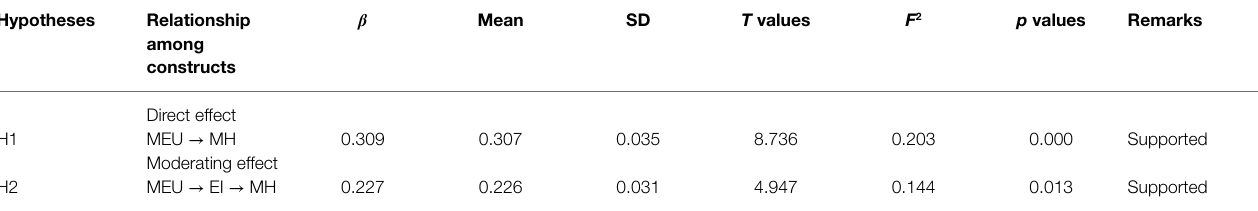
TABLE 4 | Results of structural equation